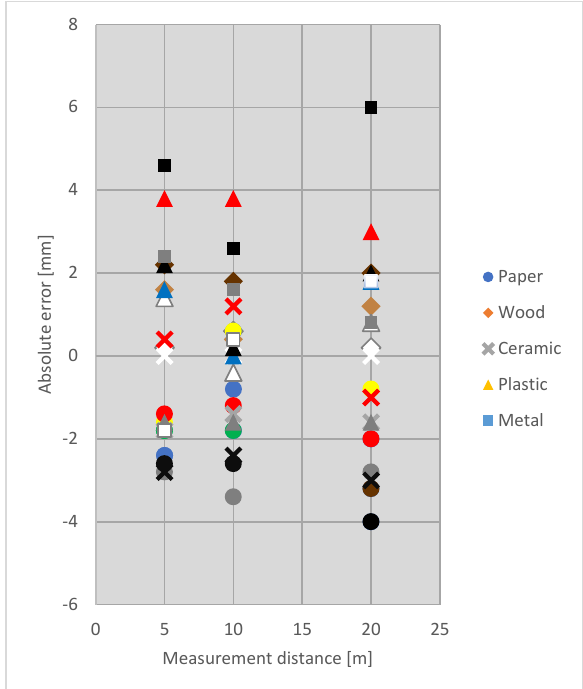
Figure 2. Mean values of absolute RL EDM errors on distances: 5, 10 and 20 m with regard to various materials and colours.